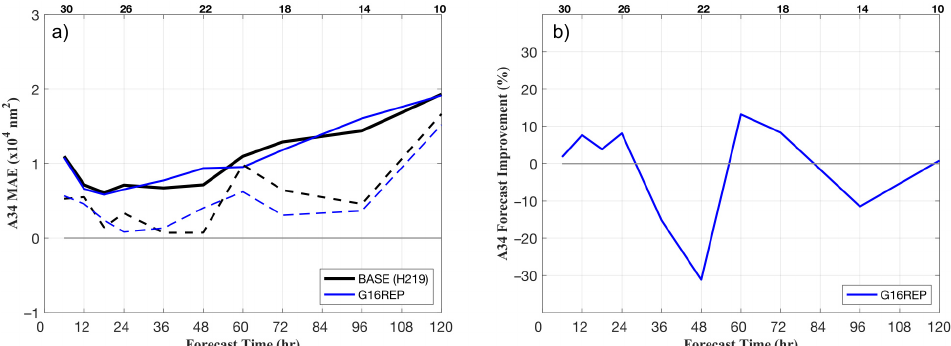
Figure 6. Hurricane Irma (2017) HWRF areal extent of 34-kt winds (A34) (10 4 nm 2 ), forecast MAE